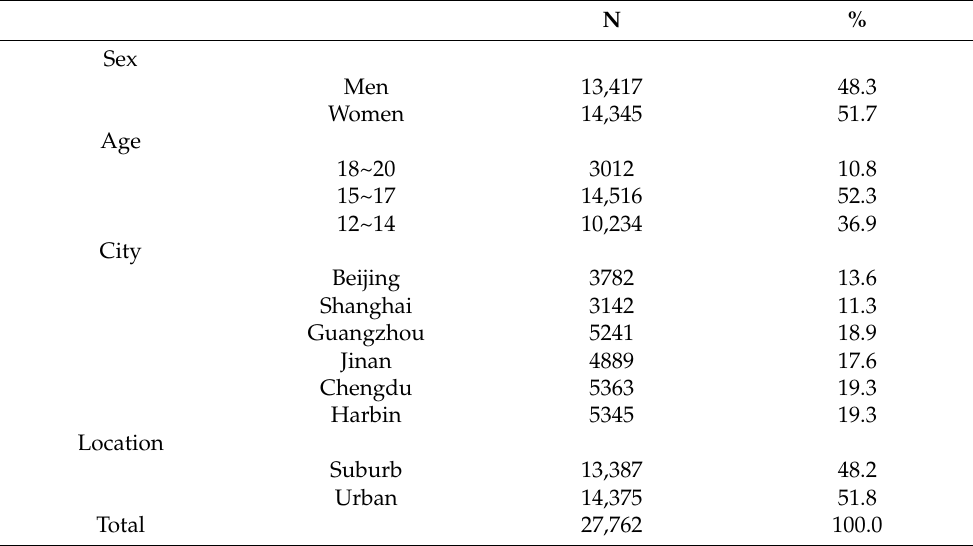
Table 1. The demographic information of participants.